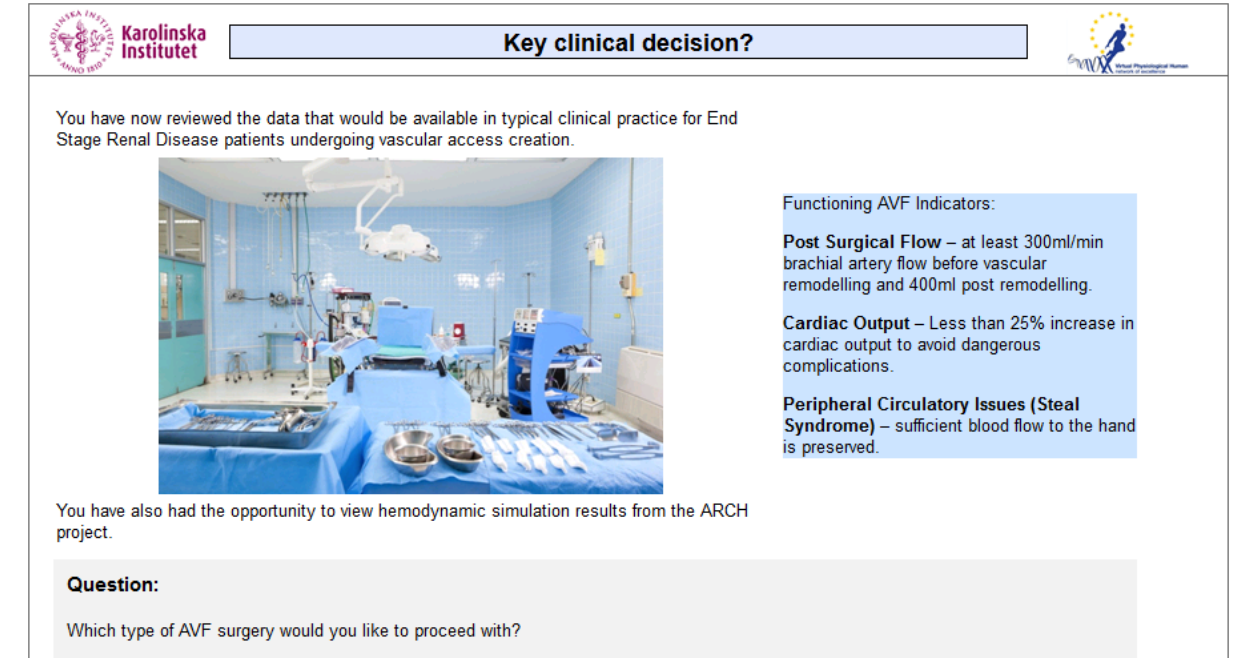
Figure 1. The virtual patient case containing archTk simulation outcome wrapped in a stand-alone, Web-enabled virtual patient